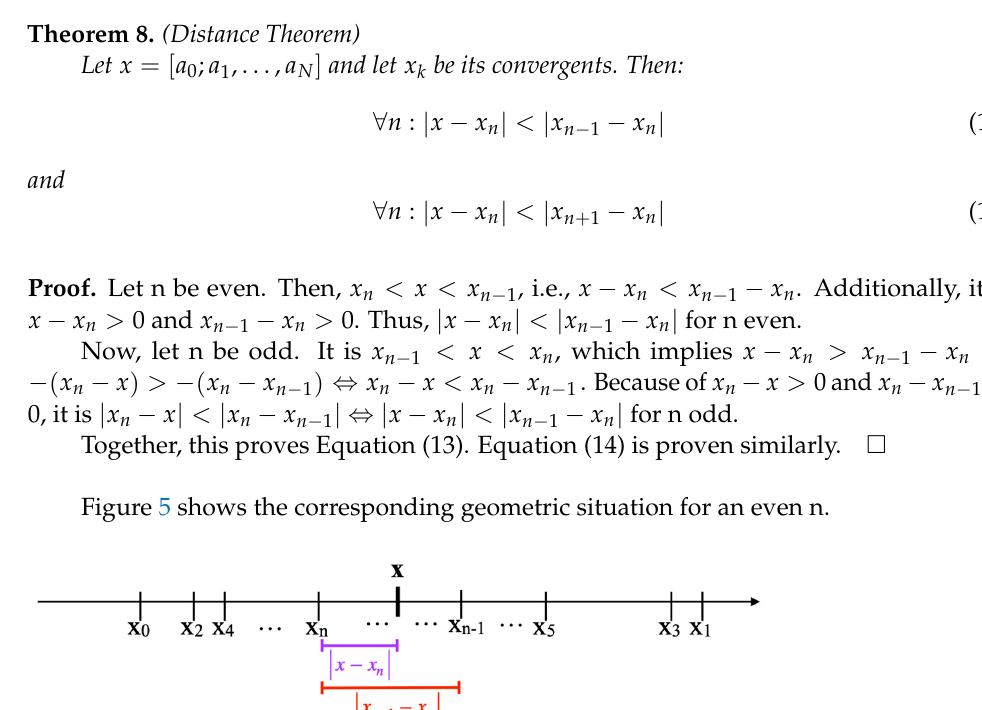
Figure 4. Nesting of the value of a continued fraction by its convergents.